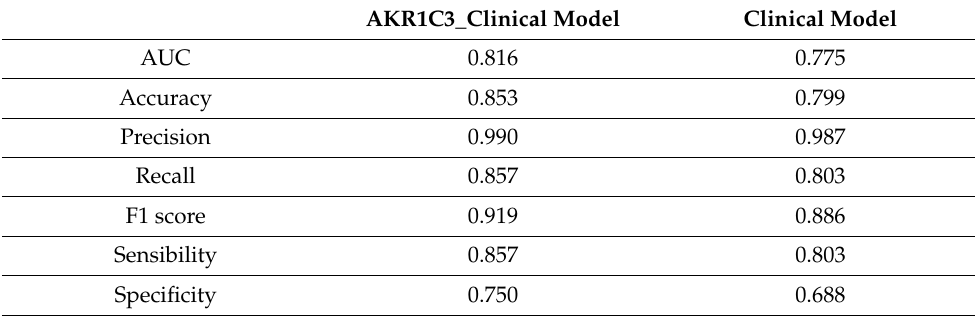
Table 2. Performances of AKR1C3_clinical model and Clinical